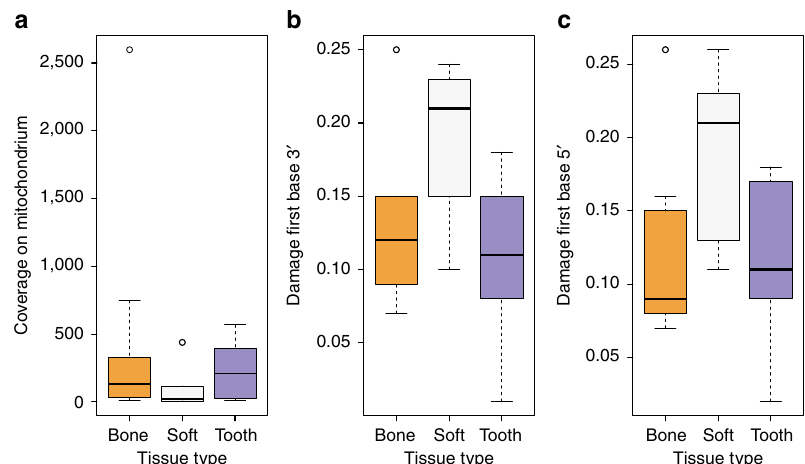
Figure 2 | DNA preservation and DNA damage of the samples used in this study. ( a ) coverage boxplots separated by tissue type (bone, mummified tissue, teeth), ( b ) boxplots showing damage of first base at the 3 0 end separated by tissue type according to a , ( c ) damage on first base at the 5 0 end of mapped reads separated by tissue type according to a and b